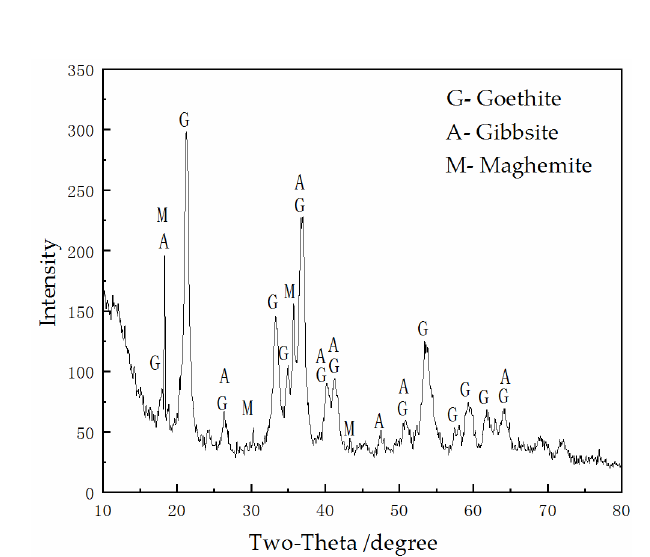
Figure 1. XRD pattern of the raw ore.